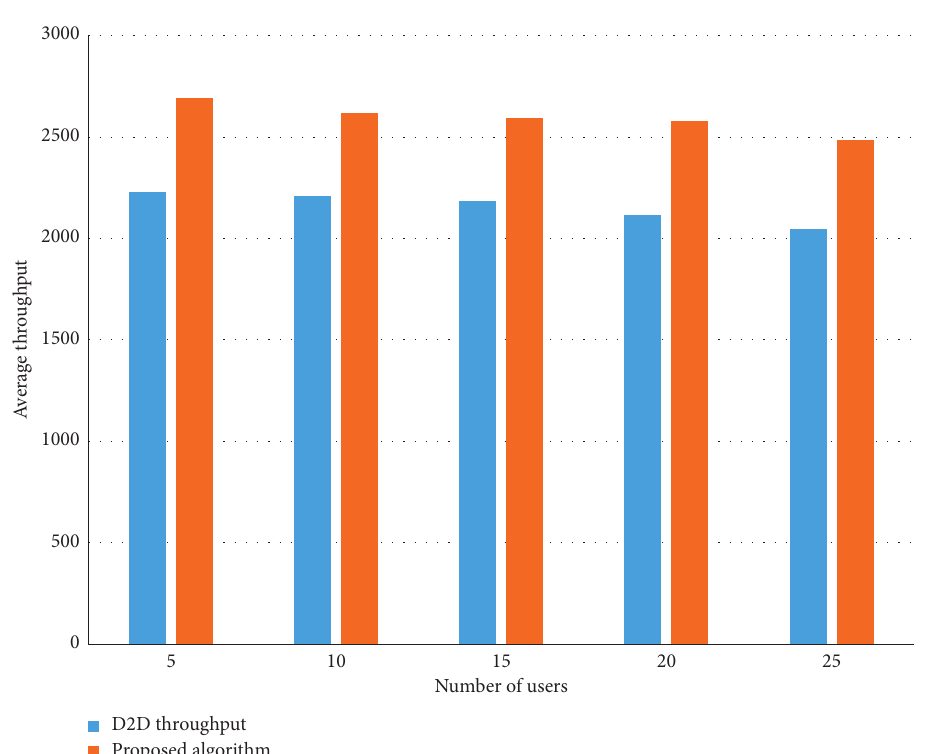
Figure 7: Average throughput against the number of